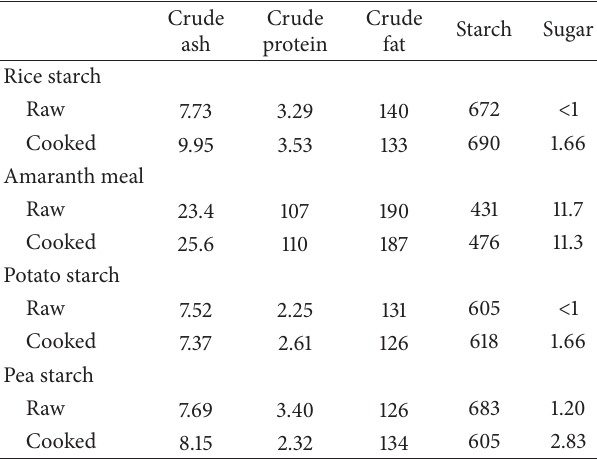
Table 2: Nutrient concentration (g/kgDM) of the test diets contain- ing different sources of starch (analysed values).